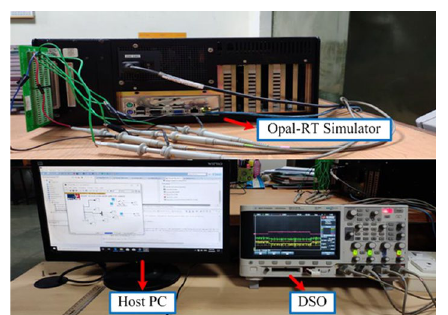
Fig. 22 Setup picture of the OPAL-RT digital simulator with DSO and Host